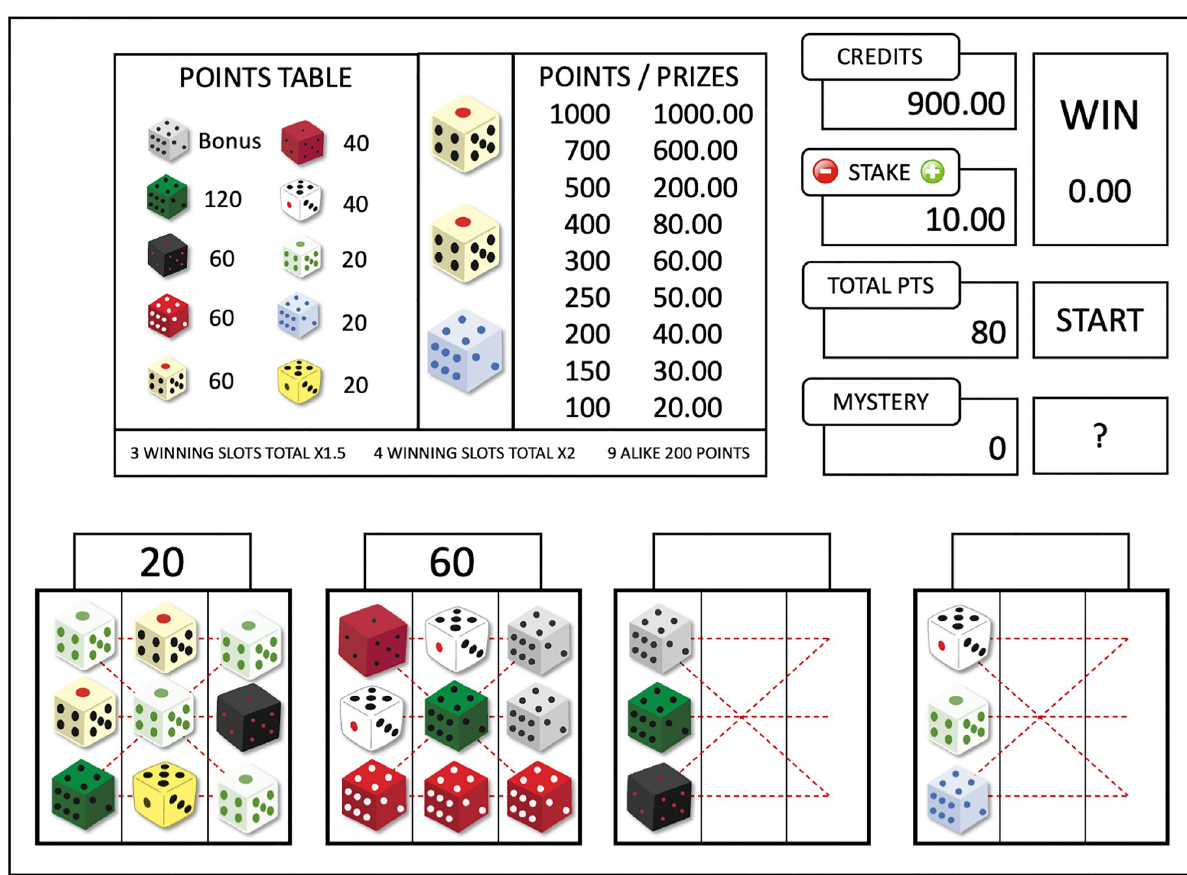
Fig 2. A schematic illustration of the game interface. In each round, players place 12 columns of dice (three dice per column) into 4 slots one by one. They win points in a slot if a horizontal or a diagonal line of the slot contains the same dice. The points from all 4 slots are added up and converted into monetary prizes (win or